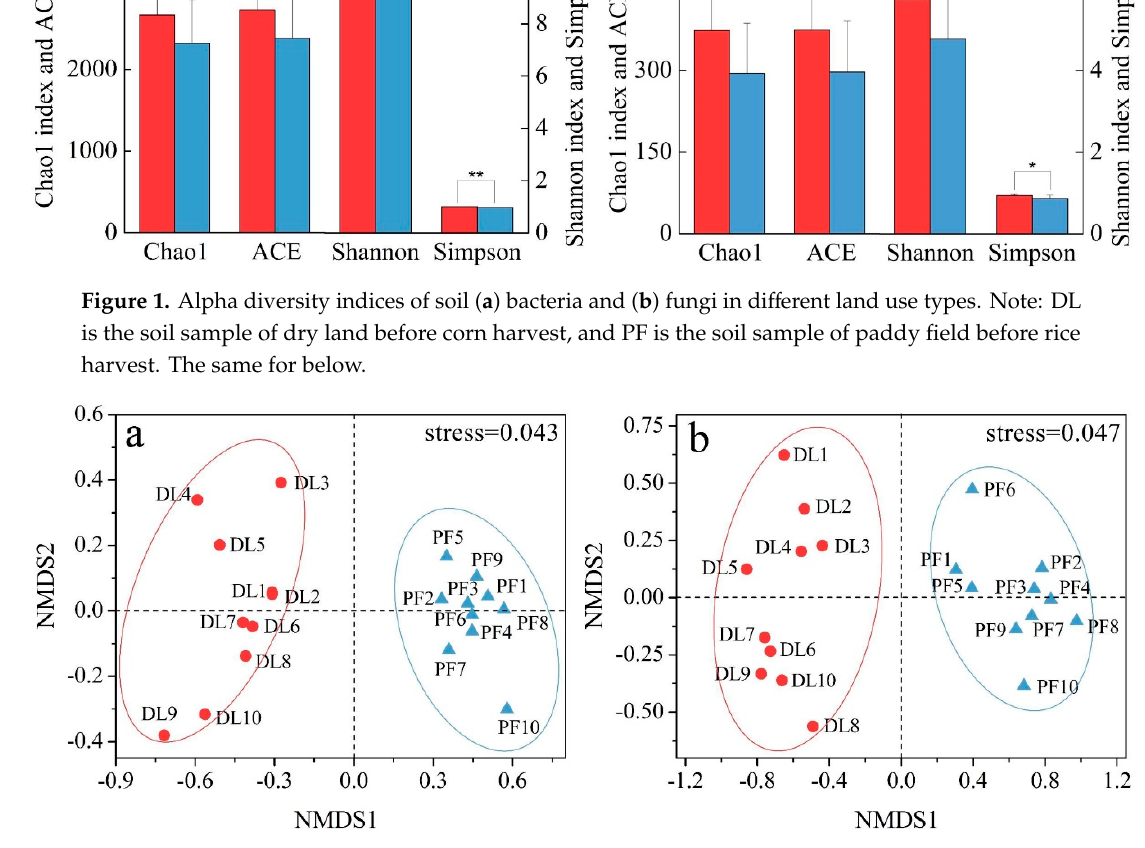
Figure 2. NMDS analysis results of soil ( a ) bacteria and ( b ) fungi at the genus level in different land use types.